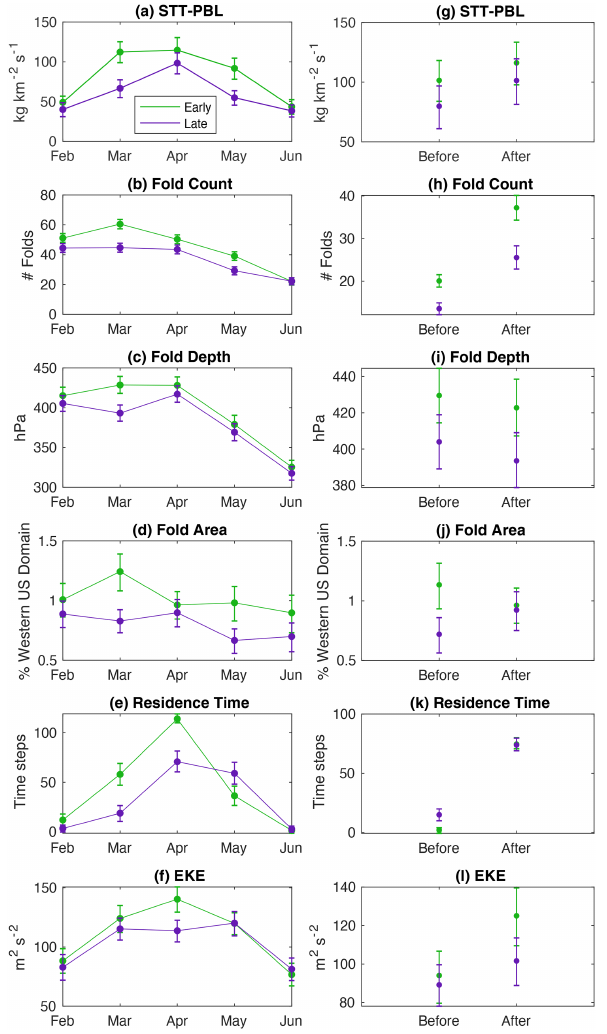
Figure 6. Bootstrapped (a) mean STT-PBL, (b) fold frequency, (c) fold depth, (d) fold size, (e) mean residence time of the jet, and (f) mean EKE for February–June during early transition years (green) and late transition years (purple). Panels (g–l) show the same variables averaged over the period 5 to 20d prior to each year’s transition date (days − 20 to − 5; Table 1), labeled “Before”, and the 2 weeks following the transition date, days 0 to + 14, labeled “After”.